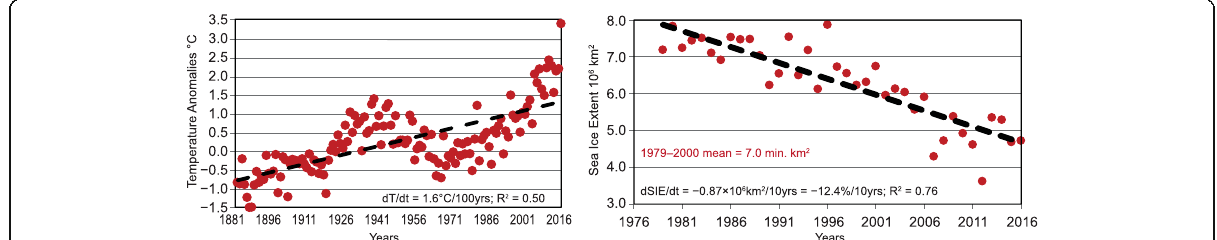
Fig. 5 Left: annual surface air temperature anomalies (°C) area-averaged over the 60° N – 90° N latitudinal zone (Lugina et al. 2006, updated). Right: September Arctic sea ice extent, SIE, 10 6 km 2 (US National Snow and Ice Data Center, Boulder, CO, USA website, http://nsidc.org/data; date of retrieval; 30 December 2015). For possible change in 2016, see Gannon (2016). Linear trend estimates shown by dash lines are provided for demonstration purposes